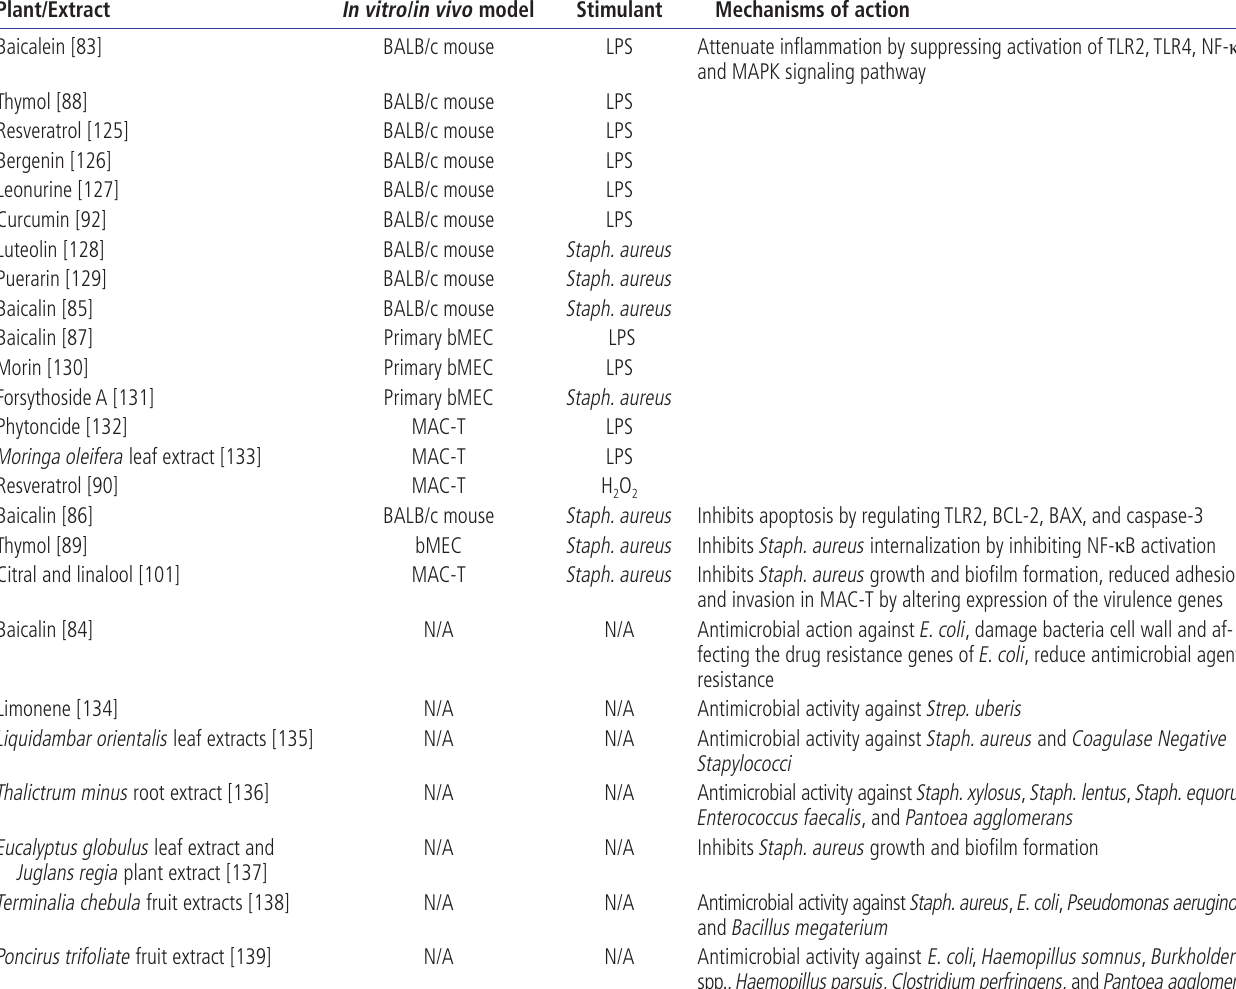
Table 1. Recent studies on plant-derived compounds against bovine mastitis